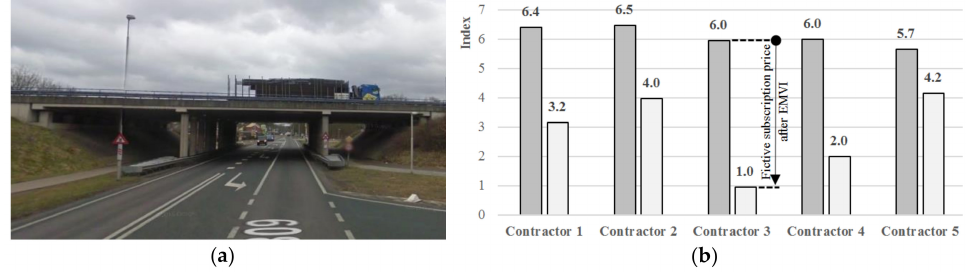
Figure 10. ( a ) Existing three-span plate bridge in the A28 / N309; ( b ) Outcome of the tender with